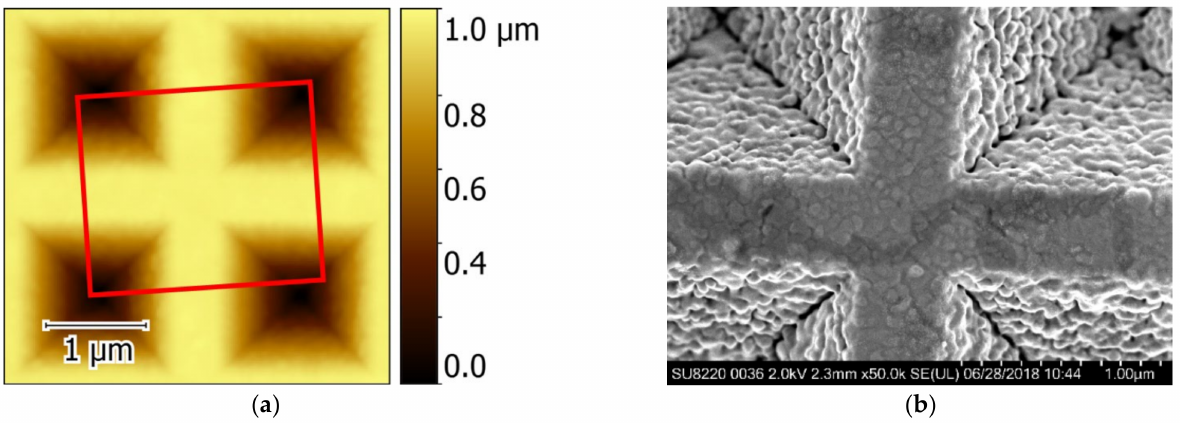
Figure 3. ( a ) AFM image of four inverted pyramids of a Klarite ® structure. ( b ) SEM image of the central fragment of the area shown in Figure 1a with a deposited submonolayer of CdSe